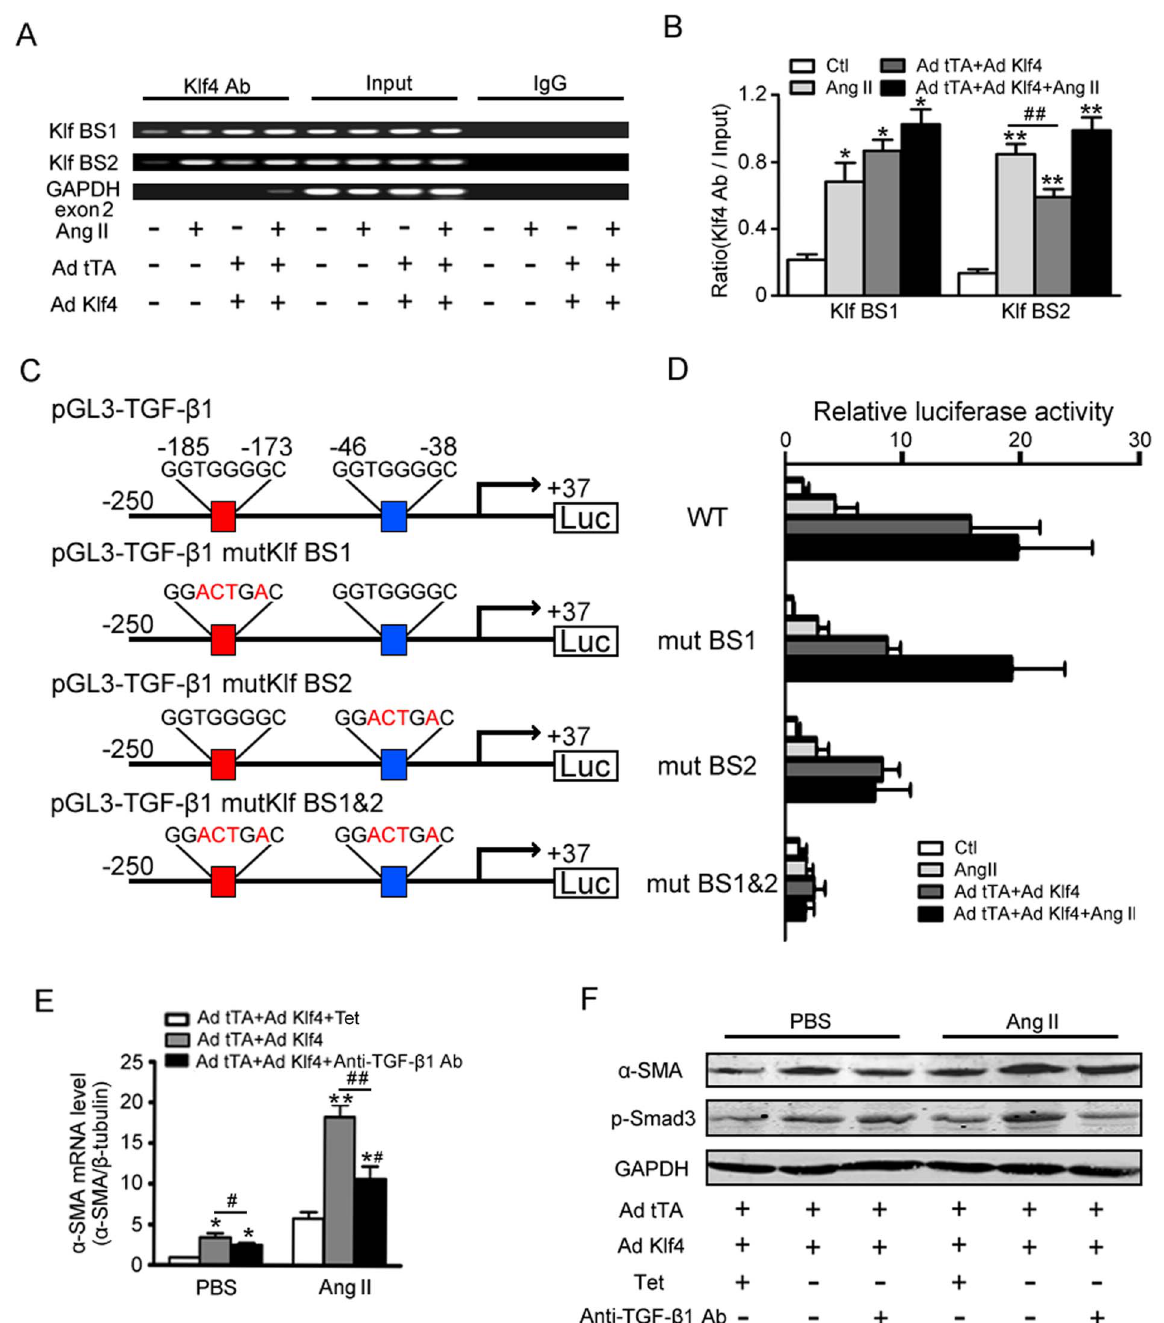
Figure 6. Klf4 transactivates the TGF- b 1 promoter. A, ChIP assays of Klf4 binding to the 2 184 , 2 180-bp site (Klf BS1) and 2 45 , 2 41-bp site (Klf BS1) of the TGF- b 1 promoter. A non-target region (GAPDH exon 2) was used as a negative control. B, normalization of each ChIP DNA fraction to the input DNA fraction using densitometric units (n=3) was shown. Data are the mean 6 SEM. *P , 0.05, **P , 0.01 vs. Ang II untreated and Klf4 non- overexpression. ## P , 0.01 vs. Ang II treatment. C, pGL3-luciferase reporter driven by the wild-type TGF- b 1 promoter or mutant (at 2 184 , 2 180-bp and 2 45 , 2 41-bp promoter sites) in which the potential Klf4-binding site was constructed. D, promoter-reporter analysis for Klf4-depedent transactivation of the TGF- b 1. The pGL3-TGF- b 1 WT or mutant vector and CMV-renilla luciferase vector were cotransfected. Luciferase activation driven by the wild-type TGF- b 1 promoter or mutant promoter and were normalized to renilla luciferase (n=4). Data are the mean 6 SEM. E-F, effects of neutralizing TGF- b 1 on the cardiac fibroblast differentiation activity. An antibody against TGF- b 1 (1 m g/ml) was added to the conditional medium. E, the effects of Klf4-dependent a -SMA mRNA expression was assessed by qPCR after Ang II treatment for 0 or 6 hrs (n=4). Data are the mean 6 SEM. *P , 0.05, **P , 0.01 vs. Klf4 non-overexpression; # P , 0.05, ## P , 0.01 vs. Klf4 overexpression. F, levels of a -SMA and p-Smad3 were assessed by Western blot after Ang II treatment for 24 hrs.